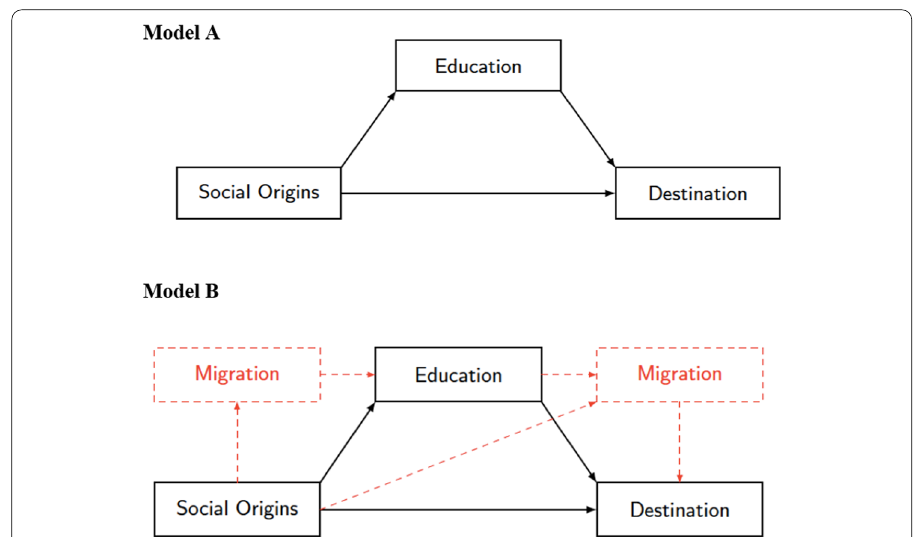
Fig. 1 The origin–education–destination model and its relationship with migration for study and migration for